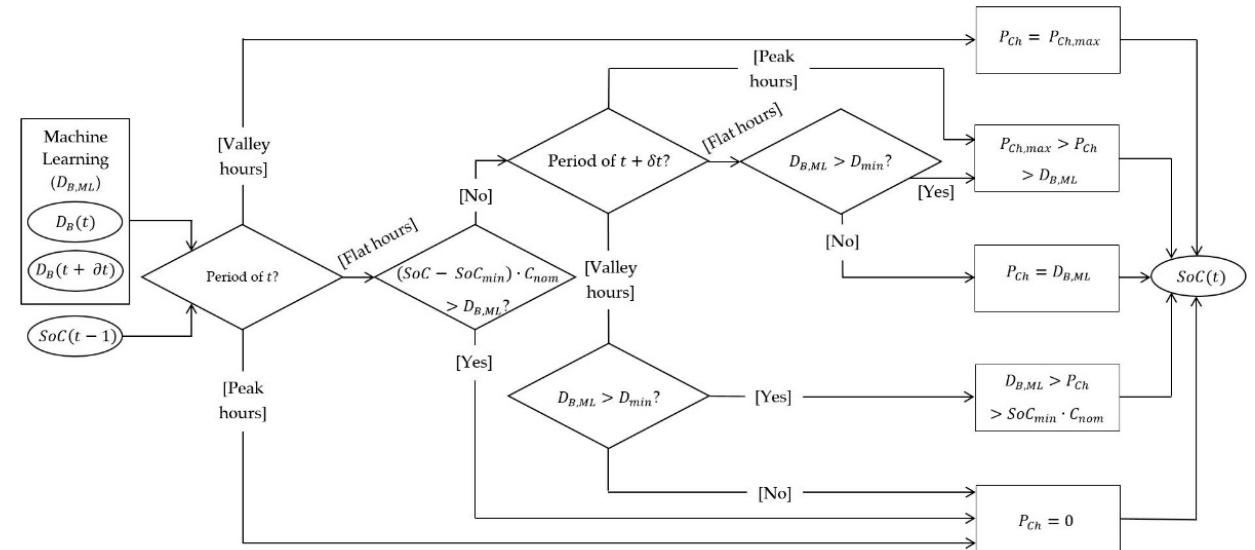
Figure 3. Storage flowchart.